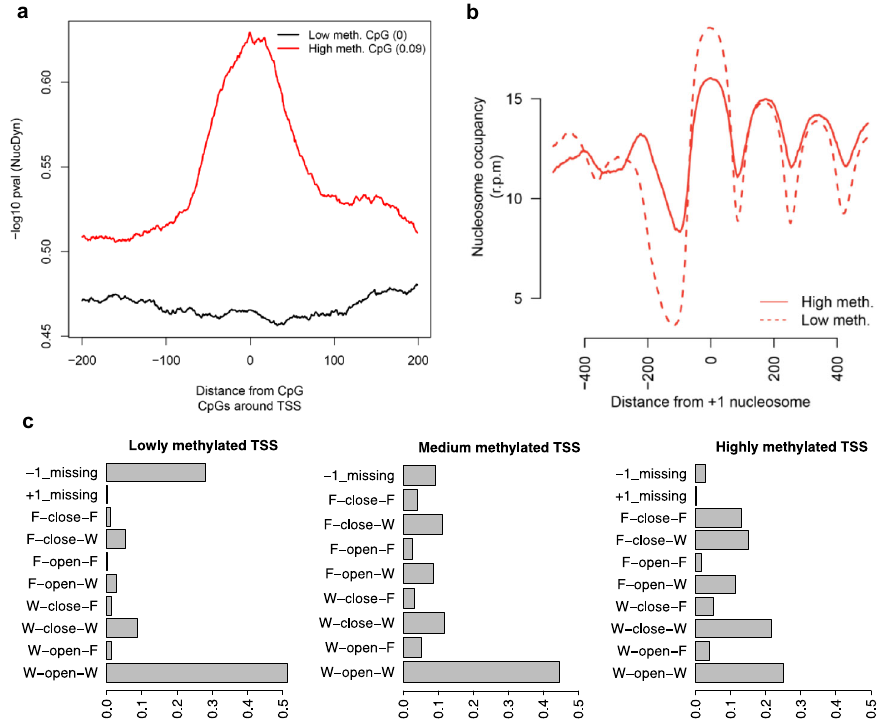
Fig. 4 Nucleosome dynamics upon methylation at promoters. a NucDyn score around highly methylated (in red) and lowly methylated CpGs (in black) at promoters. b Nucleosome coverage around + 1 nucleosome for genes with highest (top 10%, plain red lane), lowest (bottom 10%, dotted red lane) or medium (45 – 55%, doted black lane) level of CpG methylation around promoters. c Nucleosome architecture around promoters according to their methylation